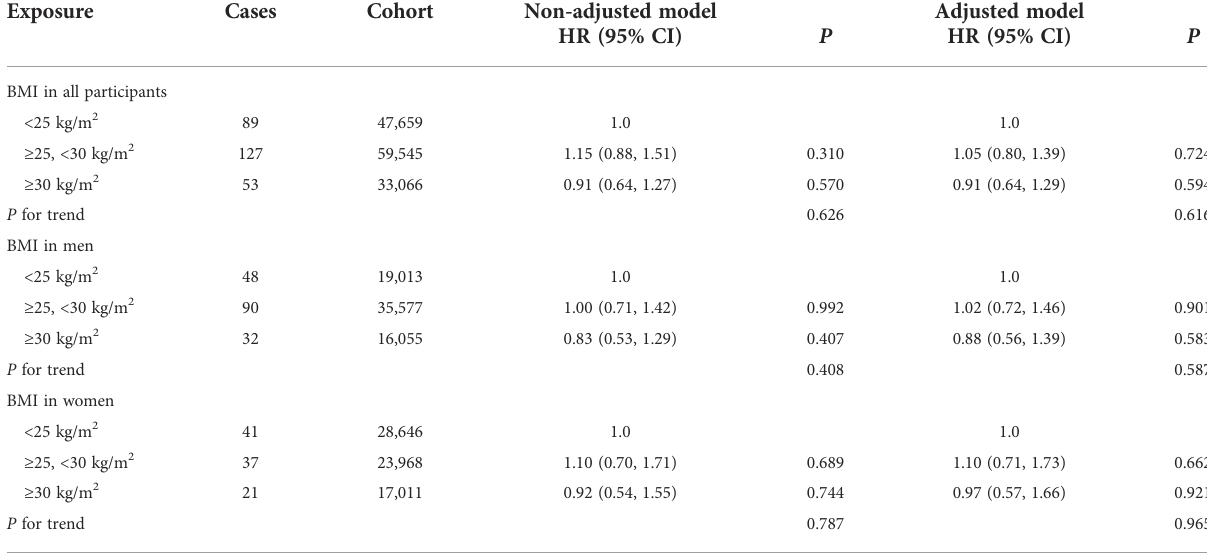
TABLE 2 HRs for the association between glioma risk and BMI at baseline. Exposure